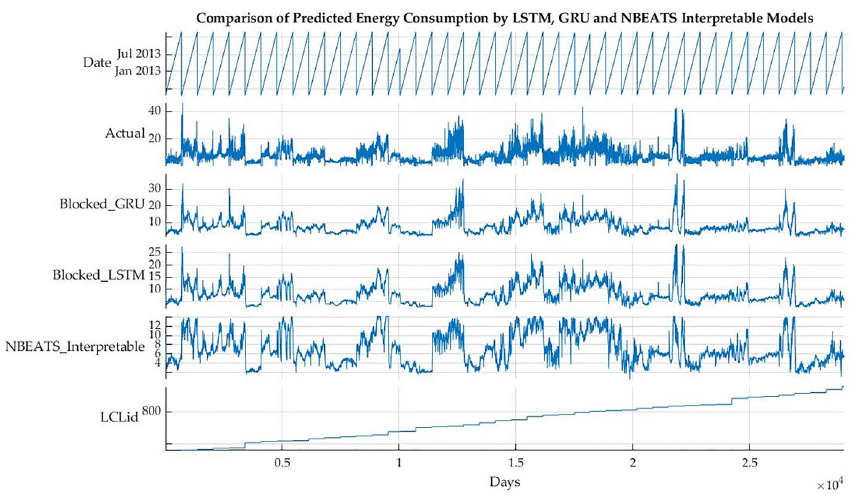
Figure 4. Performance comparison of interpretable